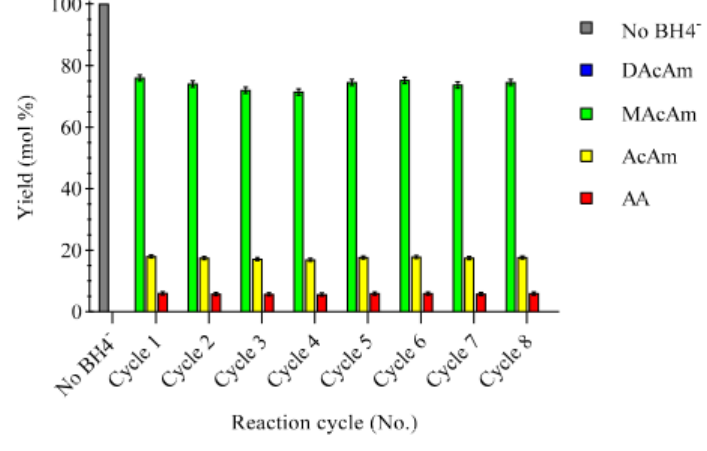
Figure 11. Dechlorination of DAcAm in repeated use of the catalyst. The dechlorination was performed in water following 15 min cycles, [DAcAm] = 8.8 mM, [NaBH 4 ] = 0.176 M, 0.10 g